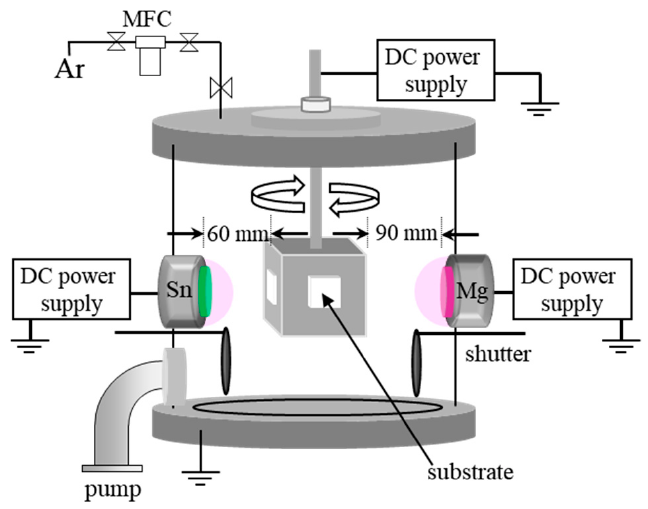
Figure 1. Schematic diagram of the DC magnetron sputtering for the fabrication of Sn/Mg film.